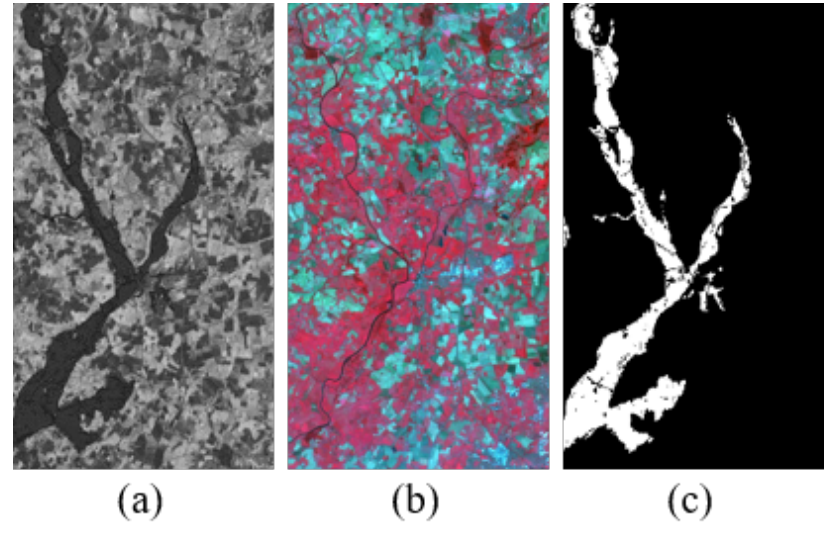
Figure 8. Gloucester dataset ( a ) ERS image. ( b ) SPOT image. ( c )